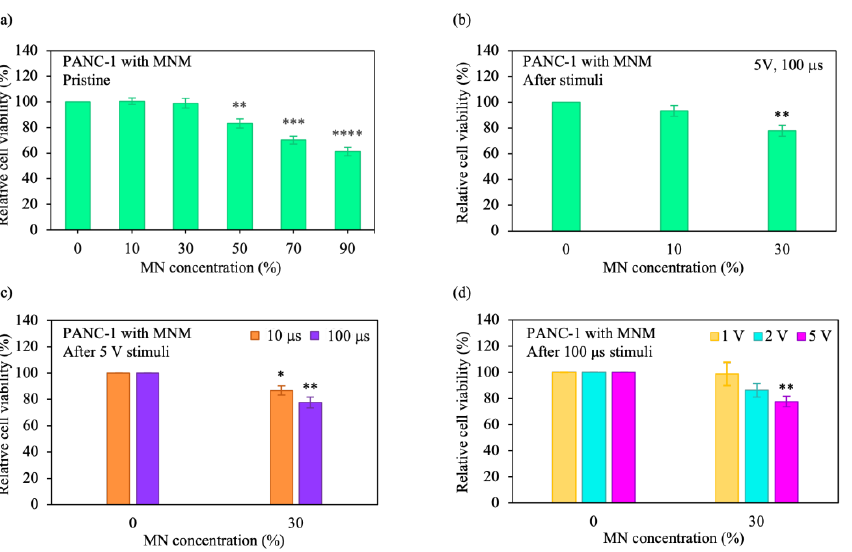
Figure 5. Cytotoxicity and electrothermal performance of MNM on ablating cancer cells. ( a , b ) Vari- ation of relative cell viabilities of the ( a ) PANC-1 cells with MNM only and ( b ) PANC-1 cells with MNM after electrical stimuli for different MN concentrations. The cell viability was measured by the WST-1 assay, and the cells were subjected to different concentrations of MN. ( c , d ) Relative cell viability variations for different (c) stimulus lengths and ( d ) pulse amplitudes. The error bars indi- cate the standard error of the mean (SEM) from three independent experiments ( 𝑛 = 6). The